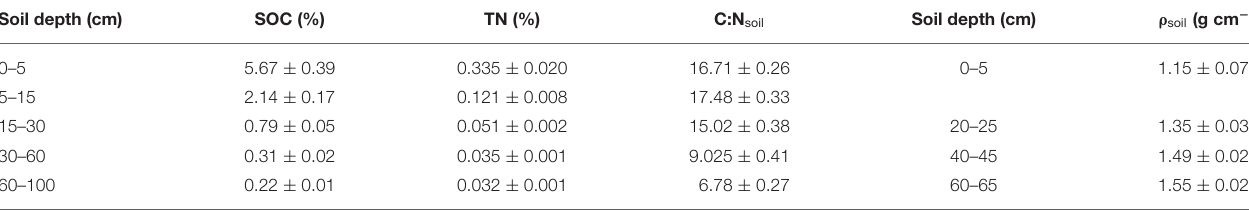
TABLE 1 | Initial soil parameters measured prior to the establishment of the trenching and leaf litter input